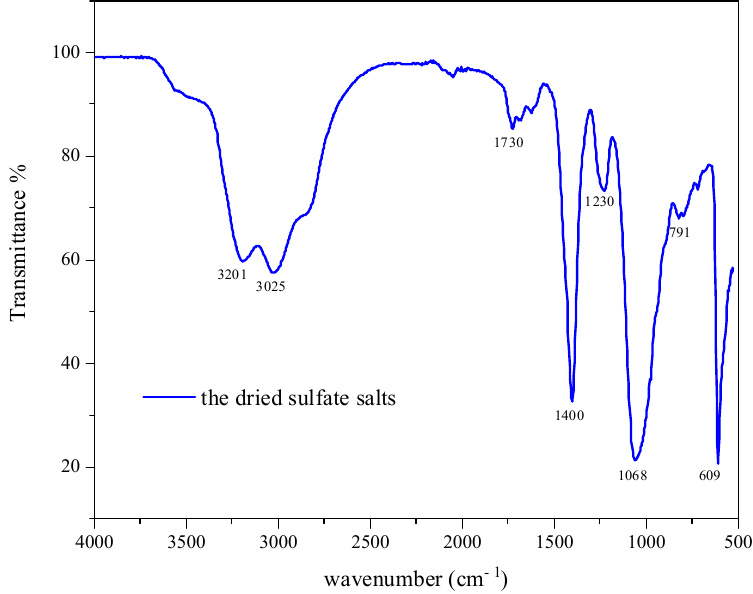
Figure 4. Infrared spectrum characterization.